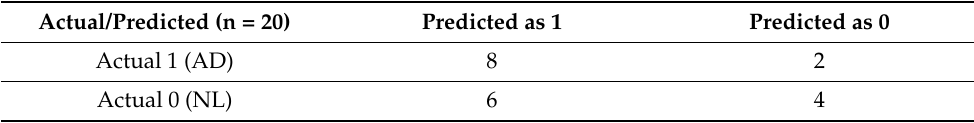
Table 7. Confusion matrix of AD/NL